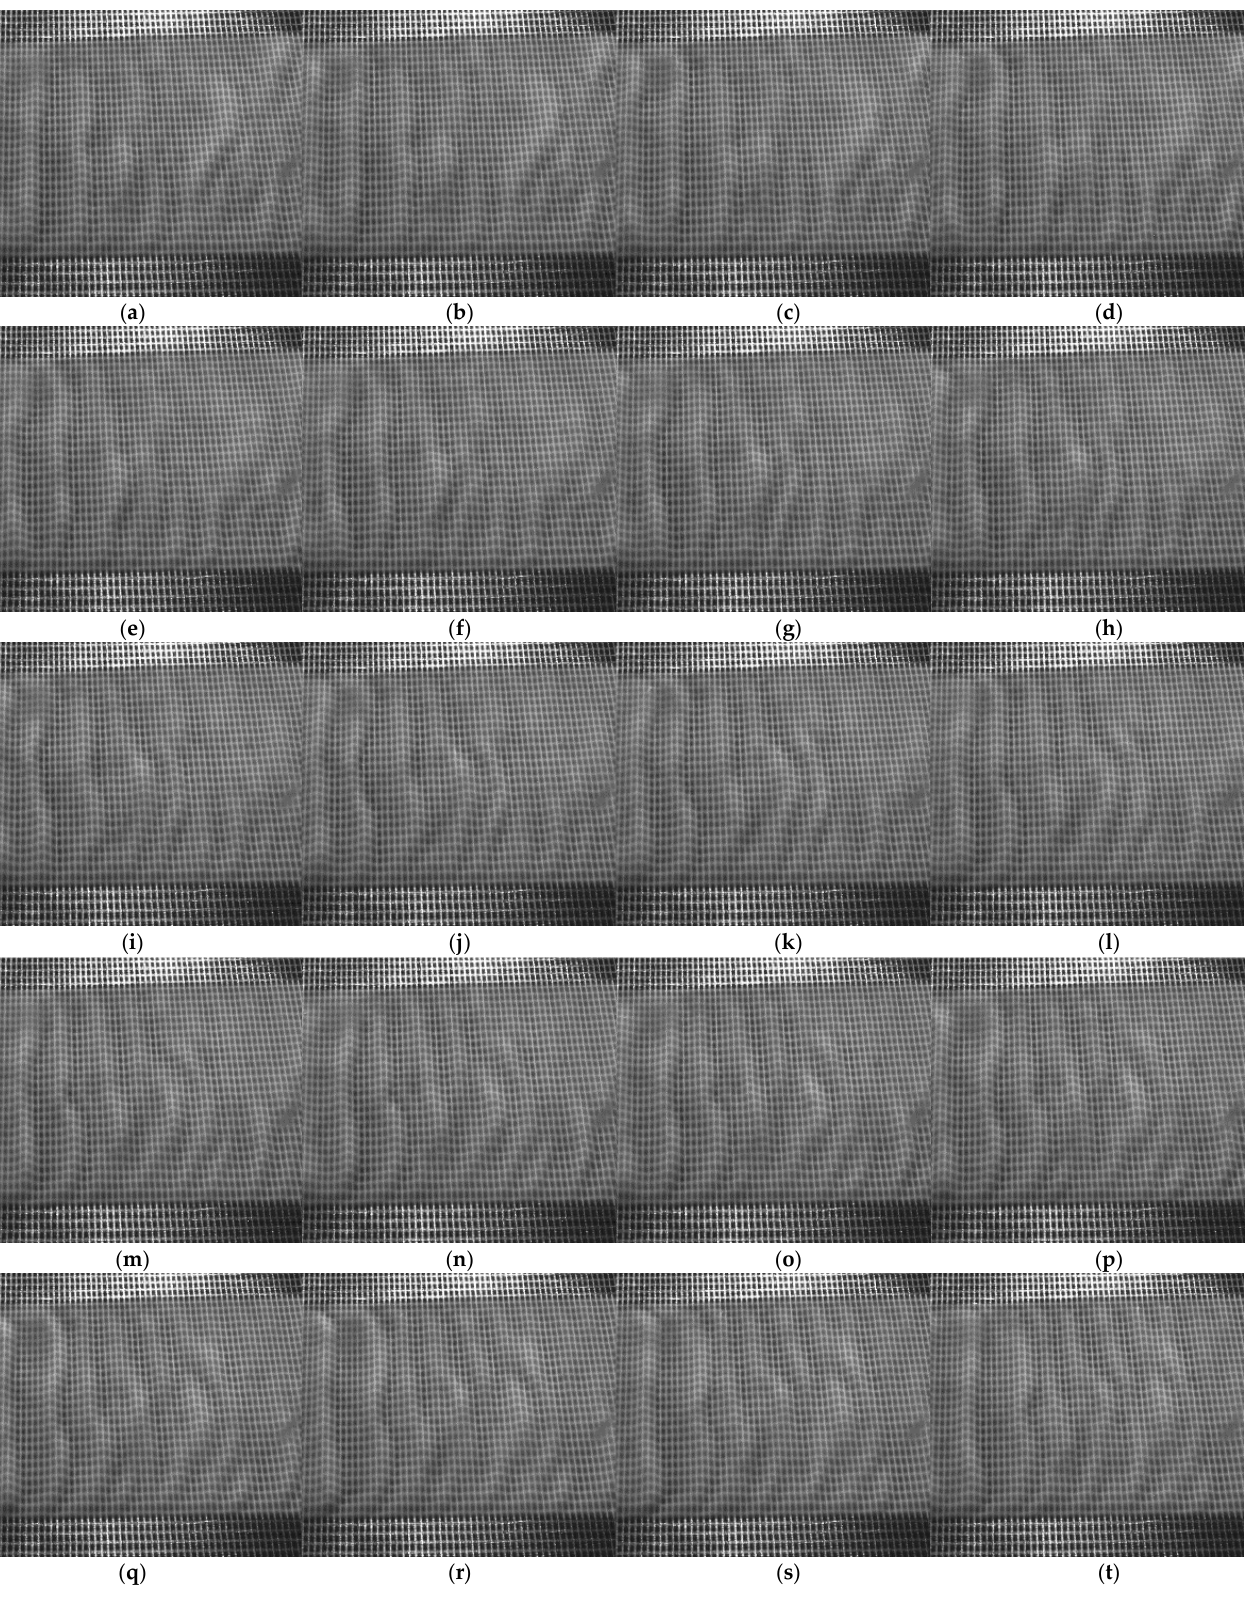
Figure 4. Images of the water film flow experiments at ( a ) t = 0 s; ( b ) t = 0.01 s; ( c ) t = 0.02 s; ( d ) t = 0.03 s; ( e ) t = 0.04 s; ( f ) t = 0.05 s; ( g ) t = 0.06 s; ( h ) t = 0.07 s; ( i ) t = 0.08 s; ( j ) t = 0.09 s; ( k ) t = 0.1 s; ( l ) t = 0.11 s; ( m ) t = 0.12 s; ( n ) t = 0.13 s; ( o ) t = 0.14 s; ( p ) t = 0.15 s; ( q ) t = 0.16 s; ( r ) t = 0.17 s; ( s ) t = 0.18 s; ( t ) t = 0.19 s.